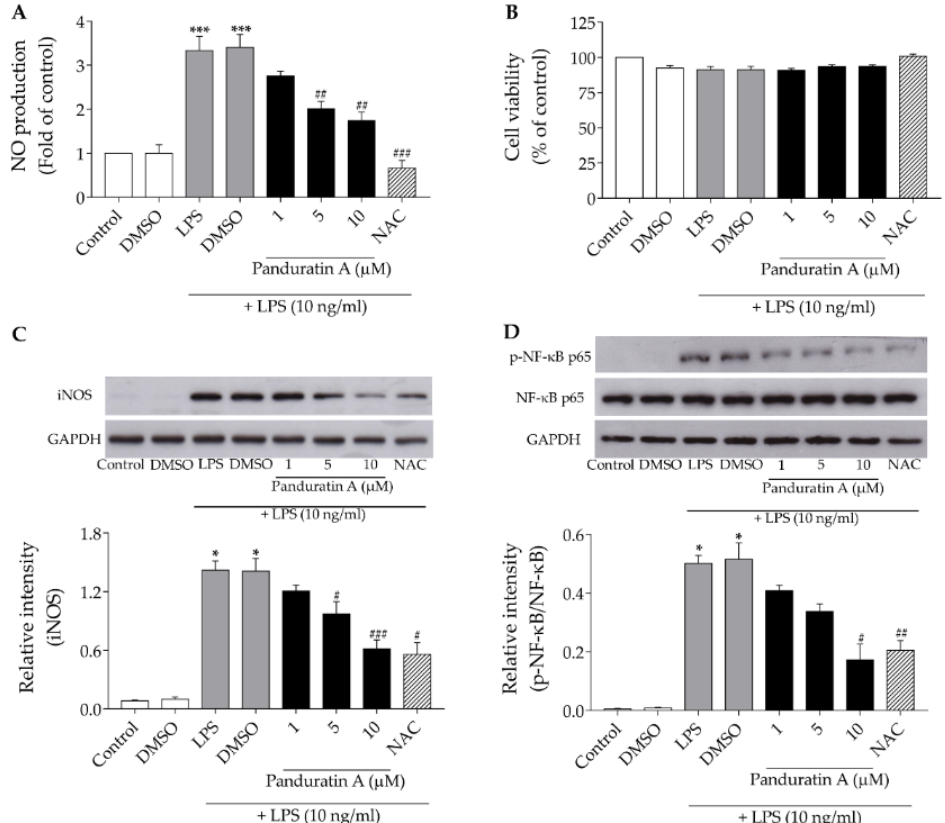
Figure 2. Effect of panduratin A against LPS-stimulated NO production, iNOS expression, and NF- κ B activation. ( A ) Inhibition of LPS-induced NO production by panduratin A; ( B ) the viability of LPS-stimulated SIMA9 cells with or without panduratin A; ( C ) Western blot analysis of iNOS expression; ( D ) p-NF- κ B p65 Ser536 and NF- κ B p65 expression levels. NAC (10 mM) was used as the positive control. * p < 0.05 and *** p < 0.001 compared to control (untreated cells); # p < 0.05, ## p < 0.01, and ### p < 0.001 compared to LPS-treated cells (one- way ANOVA followed by Tukey’s test). Detailed information about the Western blotting can be found at Figures S1 and S2.